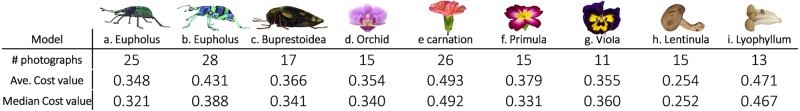
Detailed data for models in Fig 13.First row shows number of photographs used to reconstruct models in Fig 13. Second and third rows show average and median of cost values for camera position estimation in Eq (3). Notice that photographs of which matching cost were greater than or equal to 0.7 were not used for texture generation and not counted in this table.